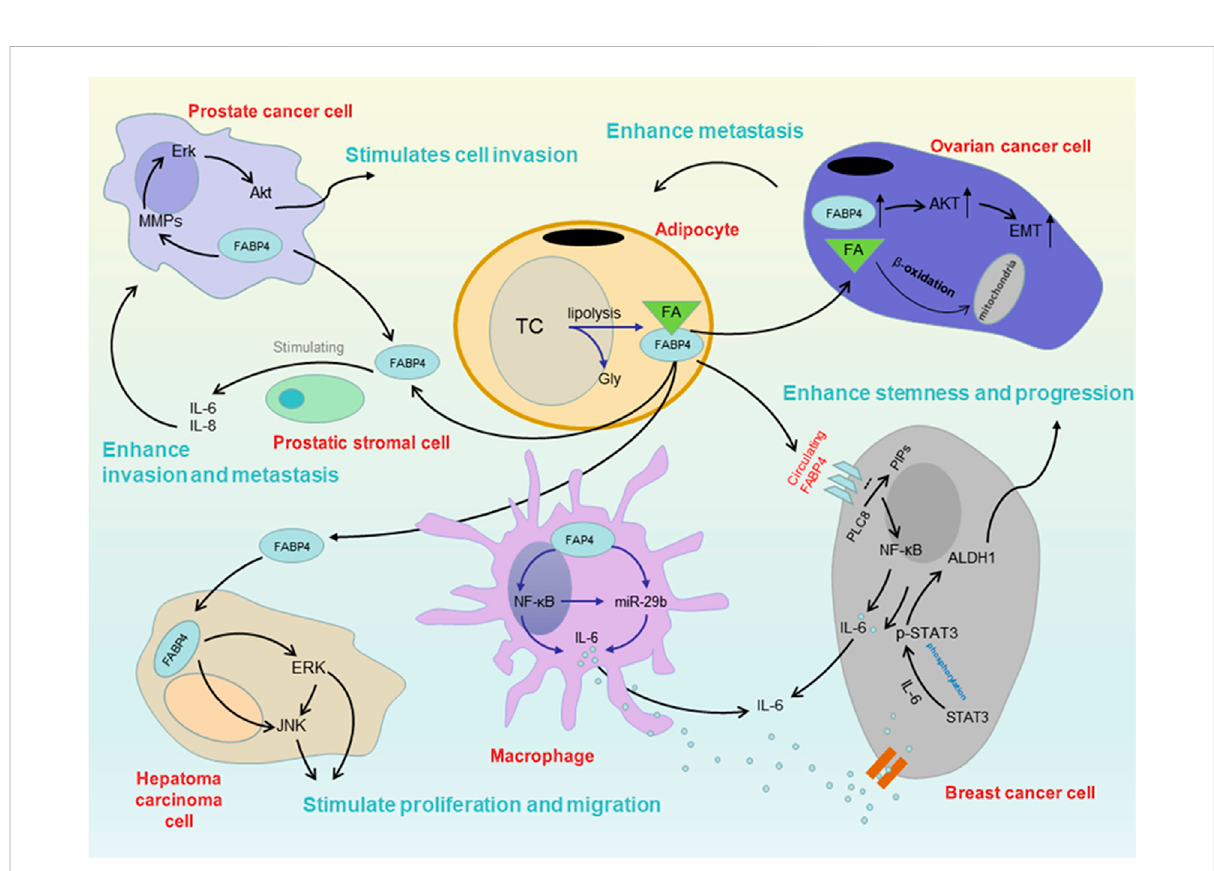
FIGURE 3 Mechanism between FABP4 and several cancers in obesity. There are some fi ndings about the mechanism. Circulating FABP4 functions as a tumor promoting factor obesity-associated breast cancer through the IL-6/STAT3/ALDH1 pathway. FABP4 could additionally activate the PI3K/AKT pathway participating in the tumor growth and survival, such as prostate cancer. The rise of FABP4 leads to a series of metabolic changes in cells, resulting in a signi fi cant reduction of miR-409-3p expression, which promotes the occurrence and development of ovarian cancer. Moreover, FABP4 could stimulate the proliferation and migration of HCC cells, promoting liver cancer